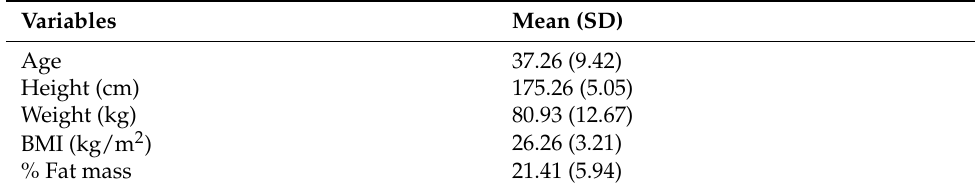
Table 1. Characteristics of